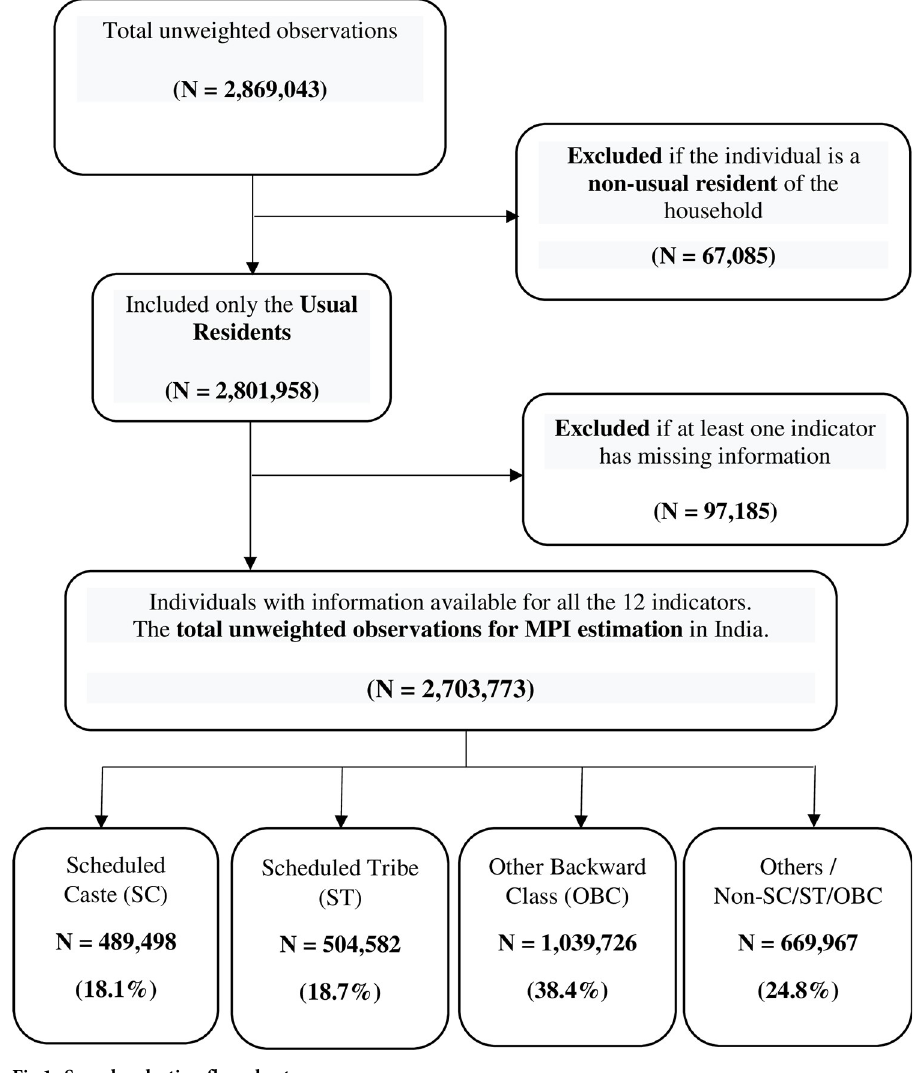
Fig 1. Sample selection flow